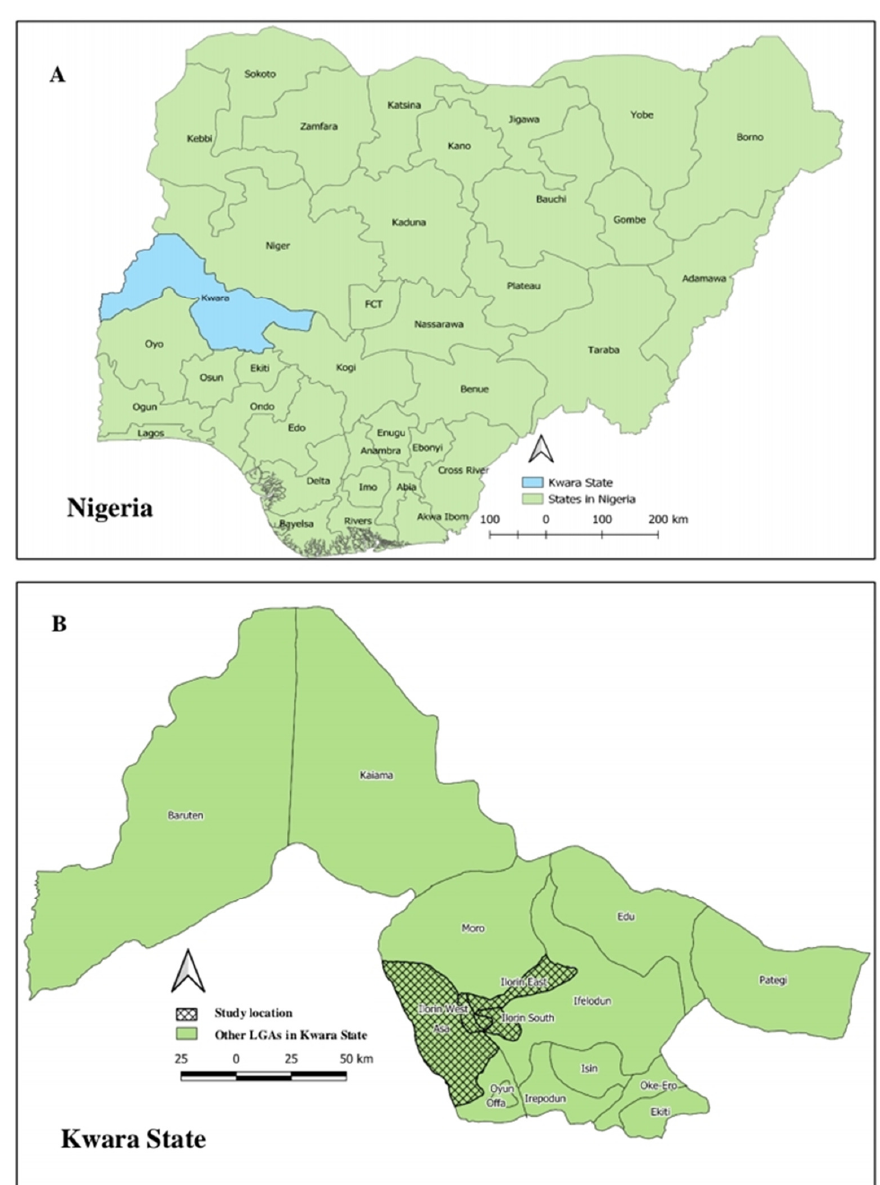
Figure 1. Map of Nigeria showing Kwara State (state of study) (A); Map of Kwara State showing the study location